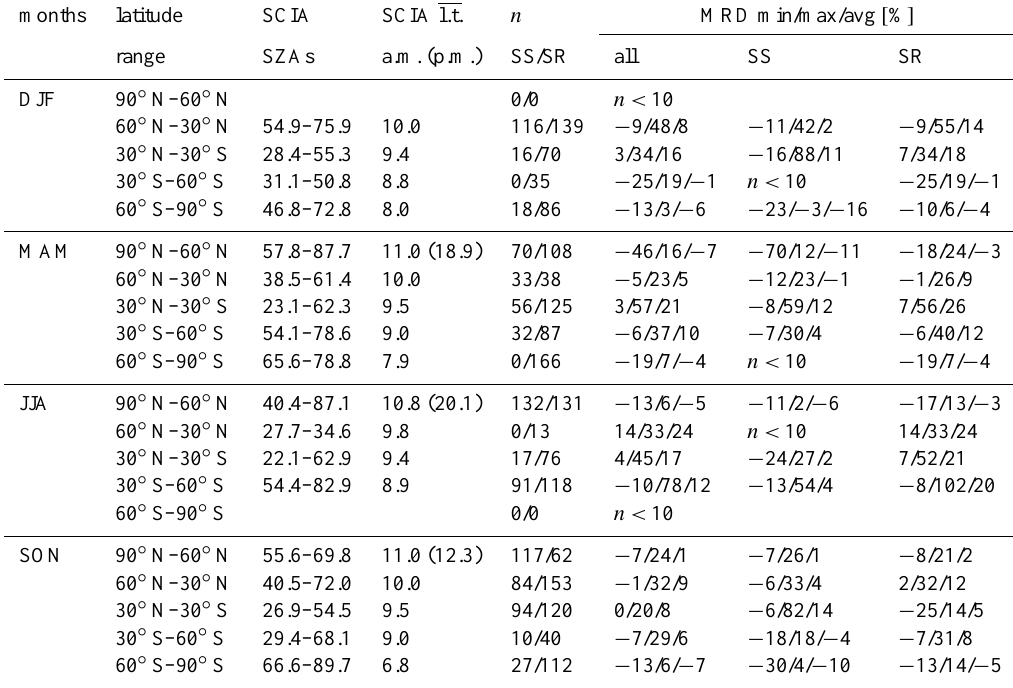
Table 3. Same as Table 2, but for HALOE collocations. An altitude range from 20 to 40km is covered. MRD corr. values are not given, as the diurnal effect error correction can not be applied for HALOE, as HALOE NO 2 is already corrected for